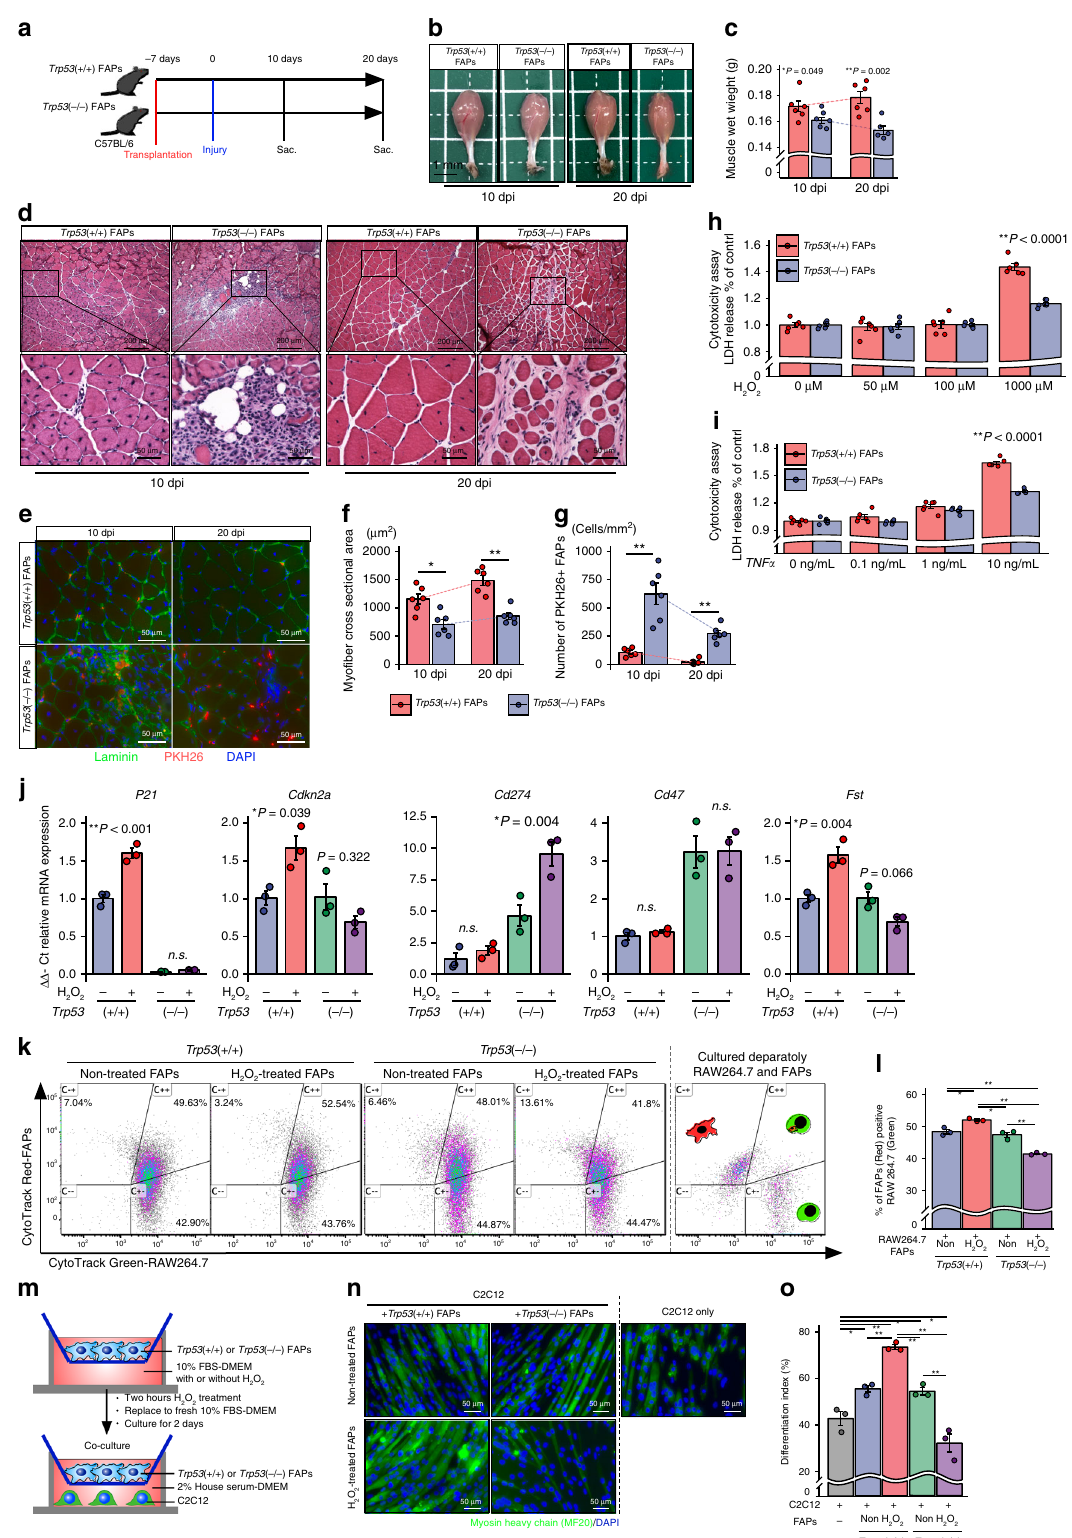
escape from the immune system and by inducing anti-phagocytic signaling, referred to as “ don ’ t fi nd me ” and “ don ’ t eat me ” sig- nals, respectively 20 . PD-L1 and PD-L2 + cells, often expressed in tumor cells and myo fi broblasts, engage and cause dysfunction in PD-1 + cells, such as T cells and macrophages 21,45 . CD47 is